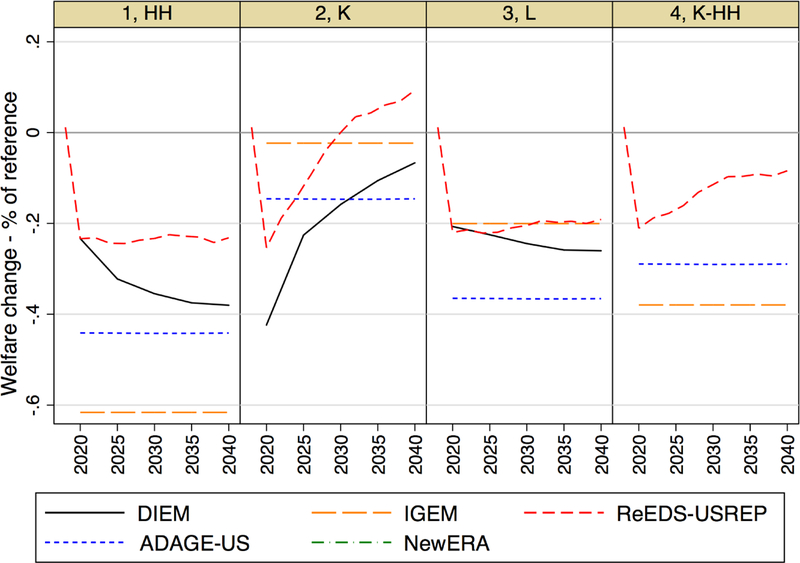
Time series of aggregate welfare change as percentage of the
no-tax reference welfare, across revenue recycling schemes and models,
$25@5% CO2 price path.